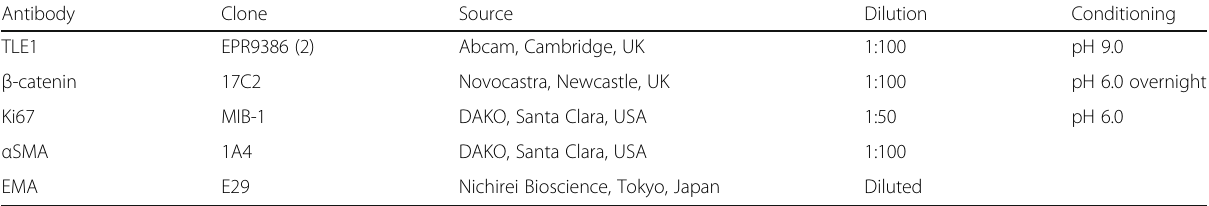
Table 3 Primary antibodies and their conditioning in this study